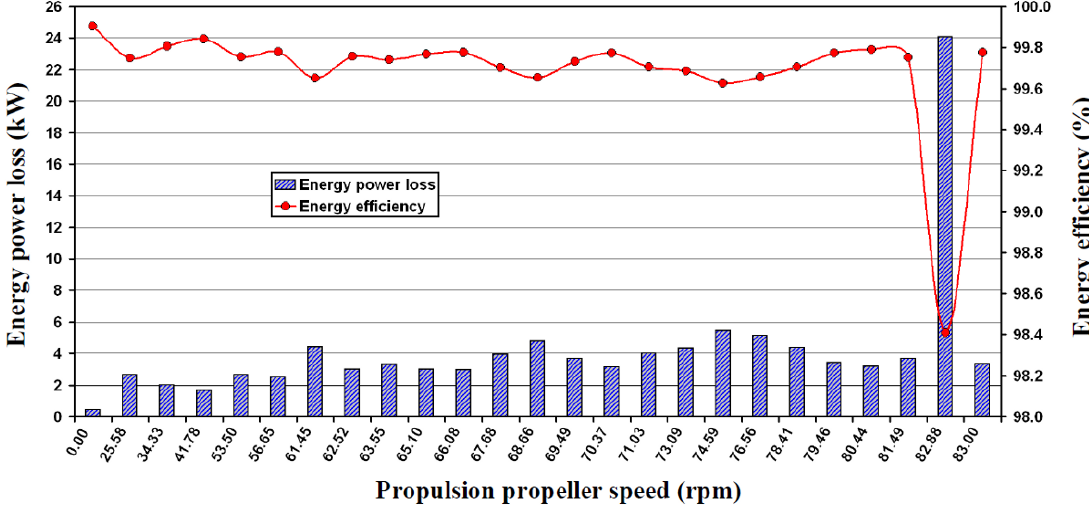
Figure 7. Energy power loss and energy efficiency of steam air heater under various